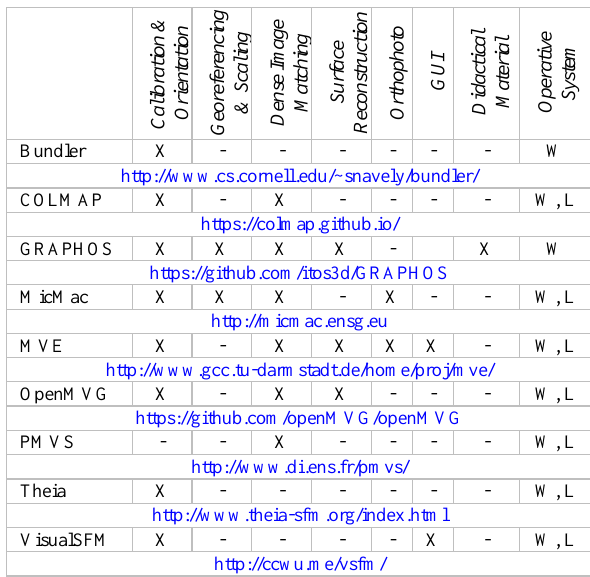
Table 2: Available open source packages for automated processing and 3D reconstruction from images. W=Microsoft Windows;